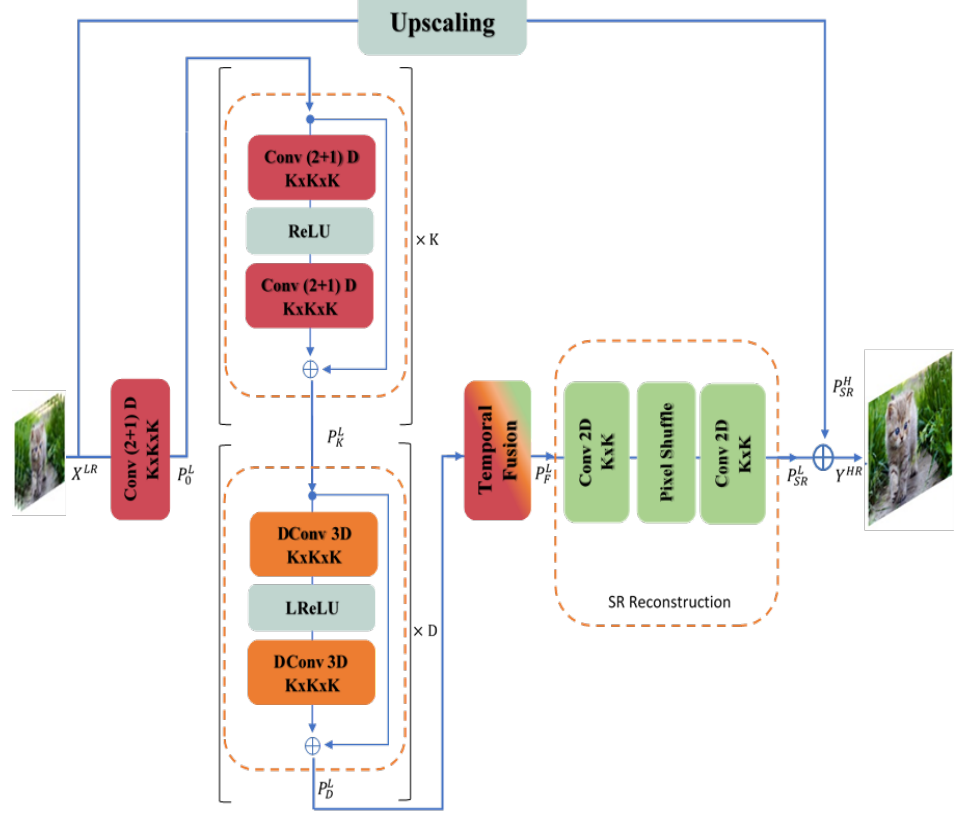
Figure 1. Proposed DSTnet architecture, the structure of a residual blocks is shown on left, and temporal fusion and reconstruction module shown on the right side of the